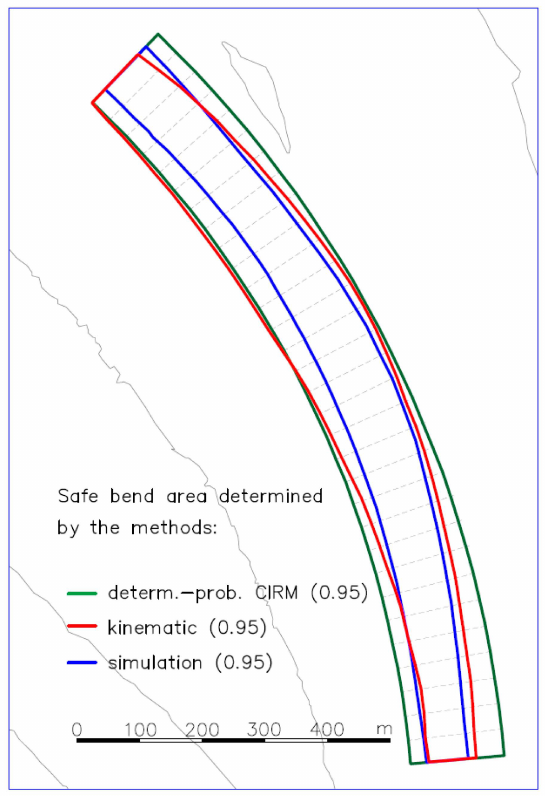
Figure 8. Safe manoeuvring areas of the I´nskie